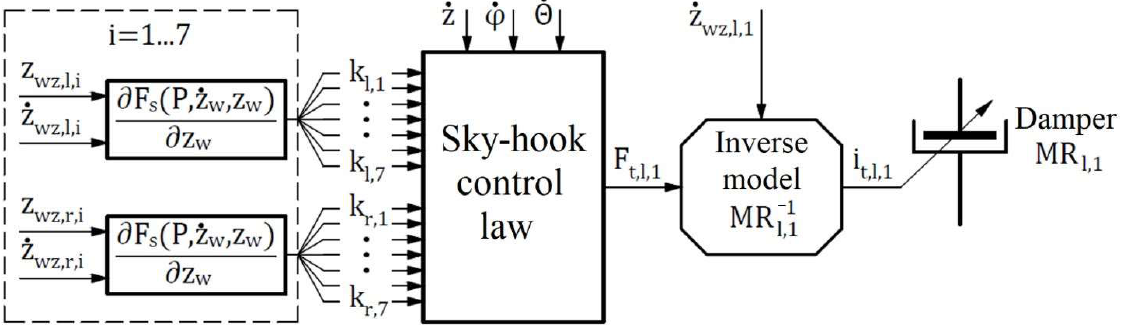
Figure A2. The control law for the magnetorheological damper on the left side and the first axis (MR l,1 ).